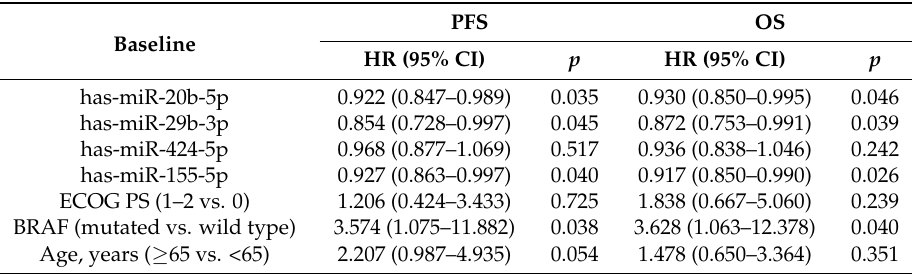
Table 4. Multivariate analysis of PFS and OS.